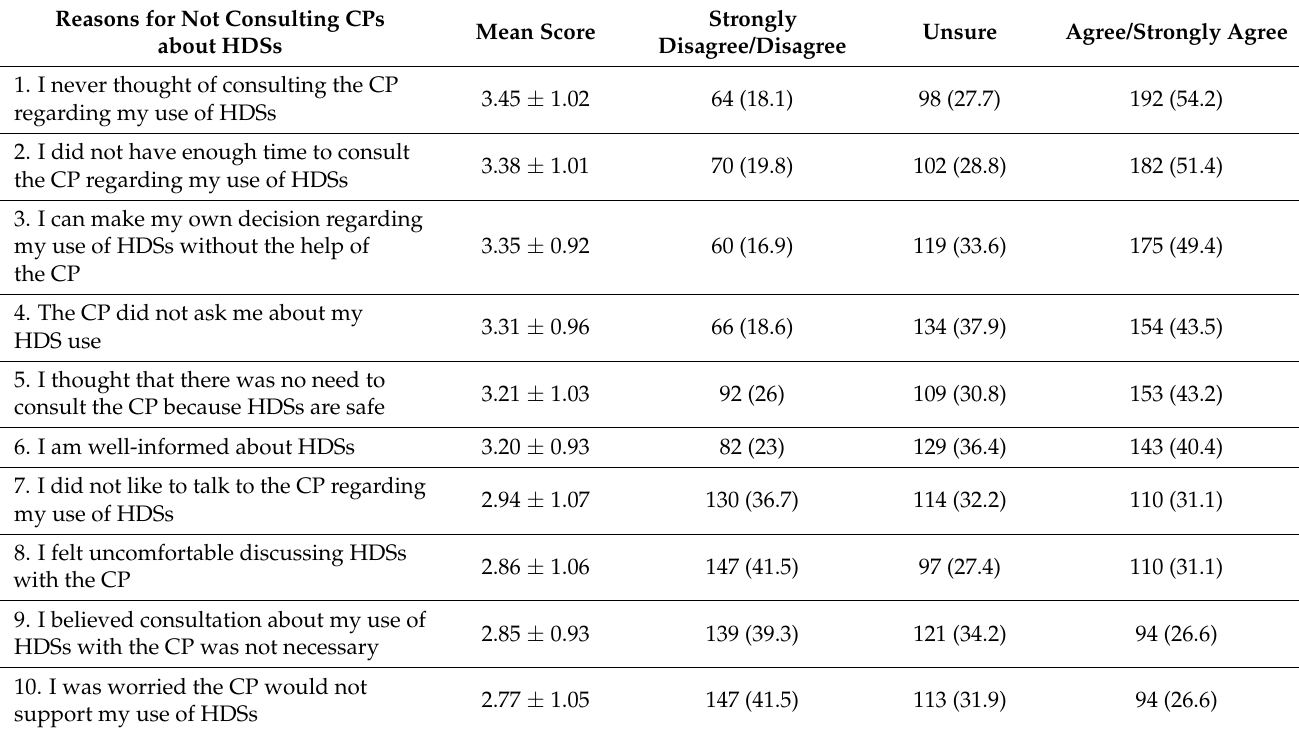
Table 5. The reasons for not consulting CPs about HDSs ( n =